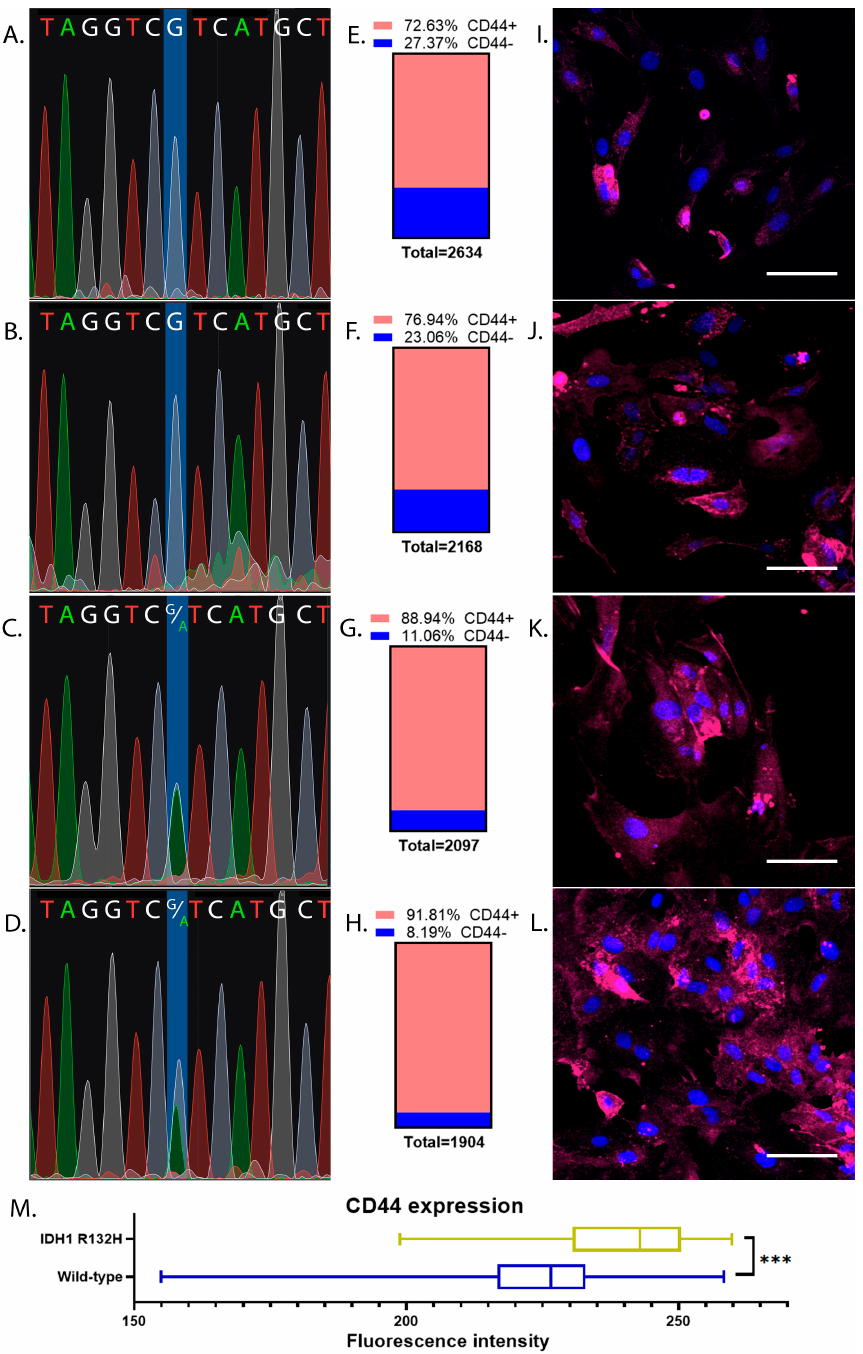
Figure 2. IDH1 sequence chromatograms and CD44 immunostaining of early-passage glioma cell cultures (P-4). Laser scanning microscopy with equal image acquisition parameters. Blue color is for DAPI, and red is for CD44. Scalebar is 100 um. ( A ) Sequence chromatogram for BT1 cell culture, IDH1 wt; ( B ) Sequence chromatogram for BT40 cell culture, IDH1 wt; ( C ) Sequence chromatogram for BT32 cell culture, IDH1 R132H mutant; ( D ) Sequence chromatogram for BT39 cell culture, IDH1 R132H mutant; ( E ) Fraction of CD44+ cells in BT1 cell culture; ( F ) Fraction of CD44+ cells in BT40 cell culture; ( G ) Fraction of CD44+ cells in BT32 cell culture; ( H ) Fraction of CD44+ cells in B391 cell culture; ( I ) CD44 labeling of BT1 cells; ( J ) CD44 labeling of BT40 cells; ( K ) CD44 labeling of BT32 cells; ( L ) CD44 labeling of BT39 cells; ( M ) CD44 labeling intensity comparison of IDH1 wild-type and IDH1 R132H mutant early-passage cell cultures. Asterisks indicate level of statistical significance: *** p ≤